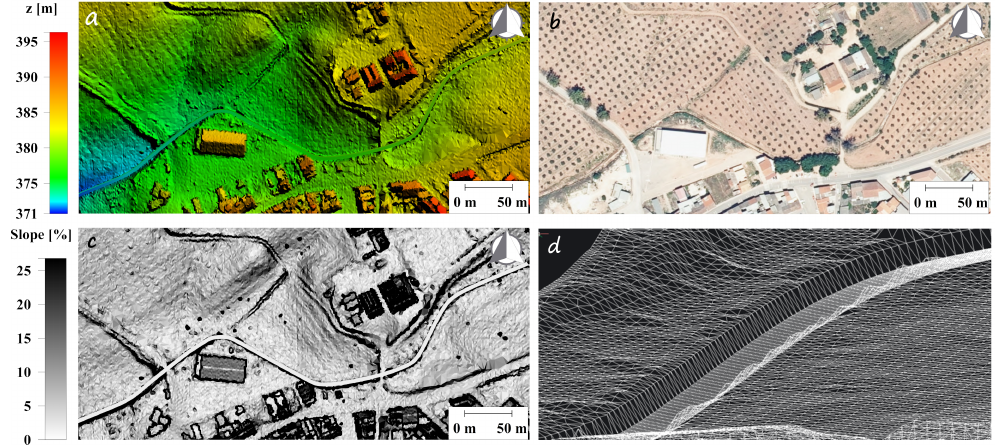
Figure 2. ( a ) DEM, ( b ) orthophoto, and ( c ) DEM slope in a small area surrounding the Arquillos town. We built the DEM from scratch using filtered LiDAR data and in-situ measurements with Leica Zeno 20 Global Positioning System (GPS). ( d ) Zoom of the computational mesh for the artificial channel and the floodplains. Note the hybrid topology of the cells with rectangular elements in the channel and triangles